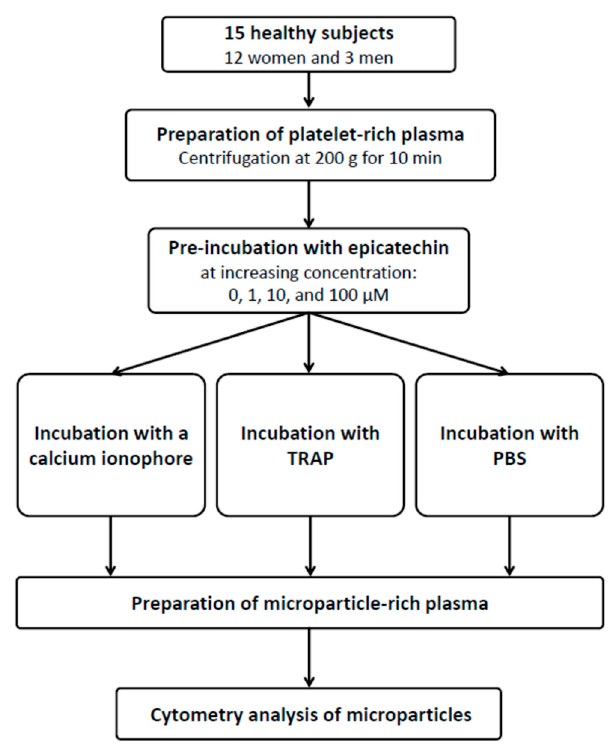
Figure A1. Study flow diagram describing the cytometry analysis of microparticles. TRAP: thrombin receptor activating peptide; PBS: phosphate bu ff ered